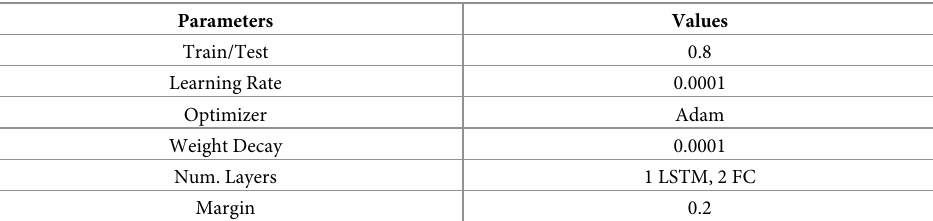
Table 3. Training parameters for